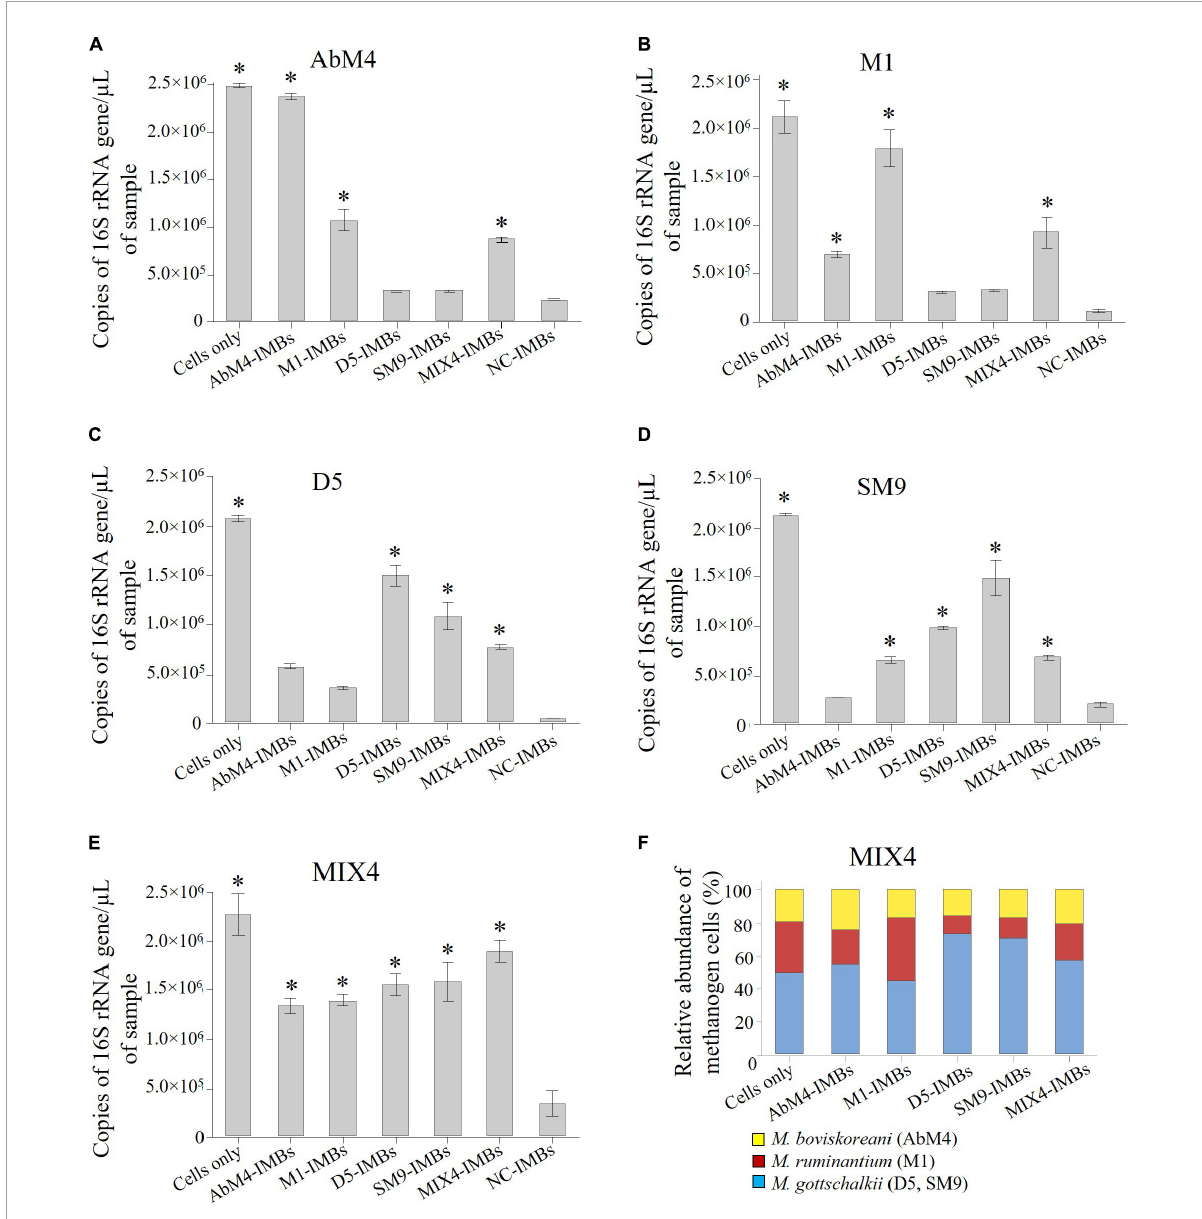
FIGURE4 Using IMBs to determine cross-reactivity of antibody-coated beads in PBS buffer. 1 × 10 8 IMBs that were coated with purified antisera produced in sheep against M. ruminantium M1, Methanobrevibacter sp. AbM4, Methanobrevibacter sp. D5, Methanobrevibacter sp. SM9, MIX4 and negative control (NC) sera were used to capture cells of each the Methanobrevibacter isolates separately. Genomic DNA was isolated from captured cells and quantified by qPCR using primers to amplify 16S rRNA gene. Copies of 16S rRNA gene/ µ L of sample are plotted against the types of IMBs used to capture the cells. NC-IMBs were used as a control, while samples containing only cells were used to determine the total count of cells present in the initial methanogen sample. (A) Capturing AbM4 cells using different IMBs; (B) Capturing M1 cells using different IMBs; (C) Capturing D5 cells using different IMBs; (D) Capturing SM9 cells using different IMBs; (E) Capturing MIX4 cells using different IMBs; (F) Relative abundance of methanogens captured by IMBs from a mix of the culture determined by the 16S rRNA gene sequencing, corrected for the number 16S rRNA gene copies present in the respective methanogen genomes. Data are presented as means ( ± SE) of three technical replicates. ∗ significantly different to negative control (NC-IMBs) group ( P <